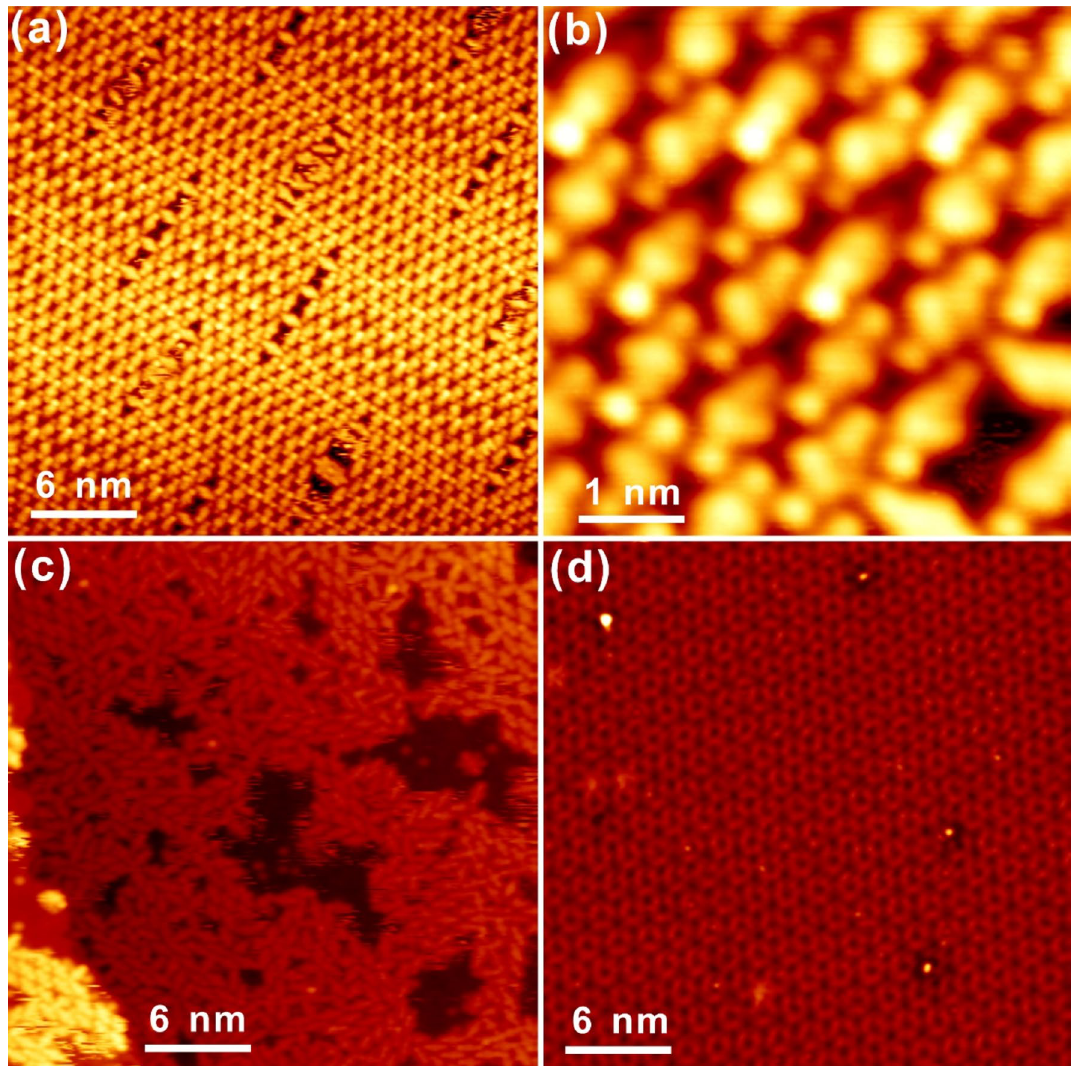
Figure 4. Investigation of the adsorption of Br 2 Py precursors on Bi–Au(111). (a) STM recording of self- assembled Br 2 Py molecules on Bi–Au(111) at RT. (b) Zoom-in STM view of the self-assembly from panel (a) . (c) Br 2 Py monomers are disorderly aligned on Bi–Au(111) after annealing to 350 K, while partial desorption of molecules can also be resolved. (d) Further annealing to 380 K inducing the complete desorption of organics, with the bare Bi–Au(111) revealed with the root 37*root 37 periodic structure. Scanning parameters: U bias = − 1.8 V, I t = 0.3